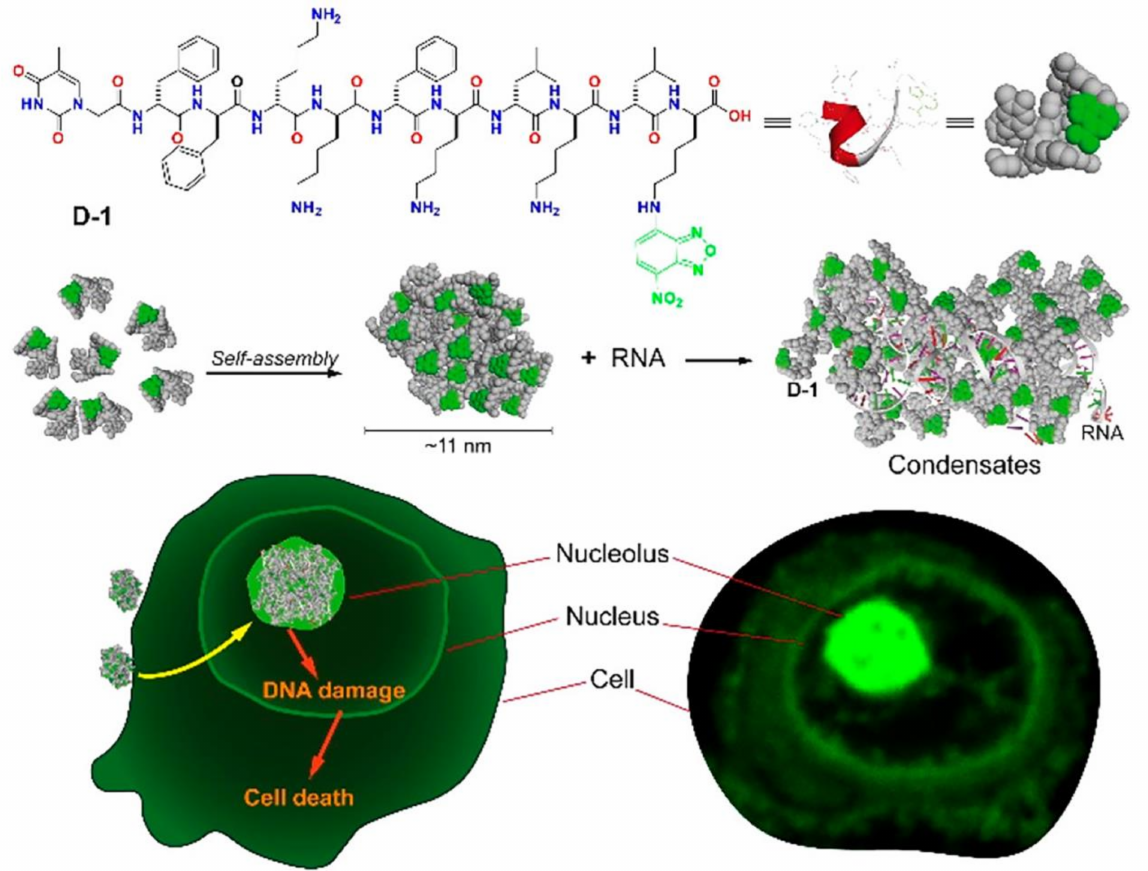
Figure 1. MolecularsStructures of D-1 and illustration of membraneless condensate formation of D-1 and RNA. Reproduced with permission from [43], American Chemical Society,